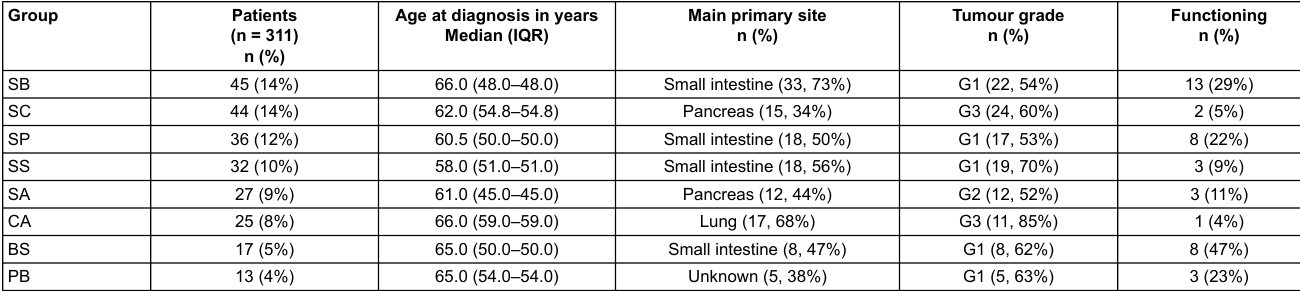
Table 4: Patient characteristics for groups defined by the first two therapies in the main analysis set.